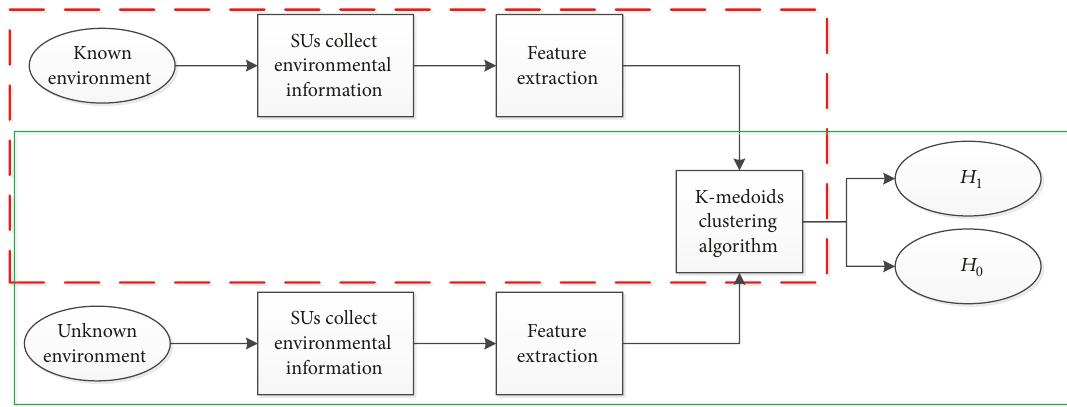
Figure 3: System model based on the K-medoids clustering algorithm.